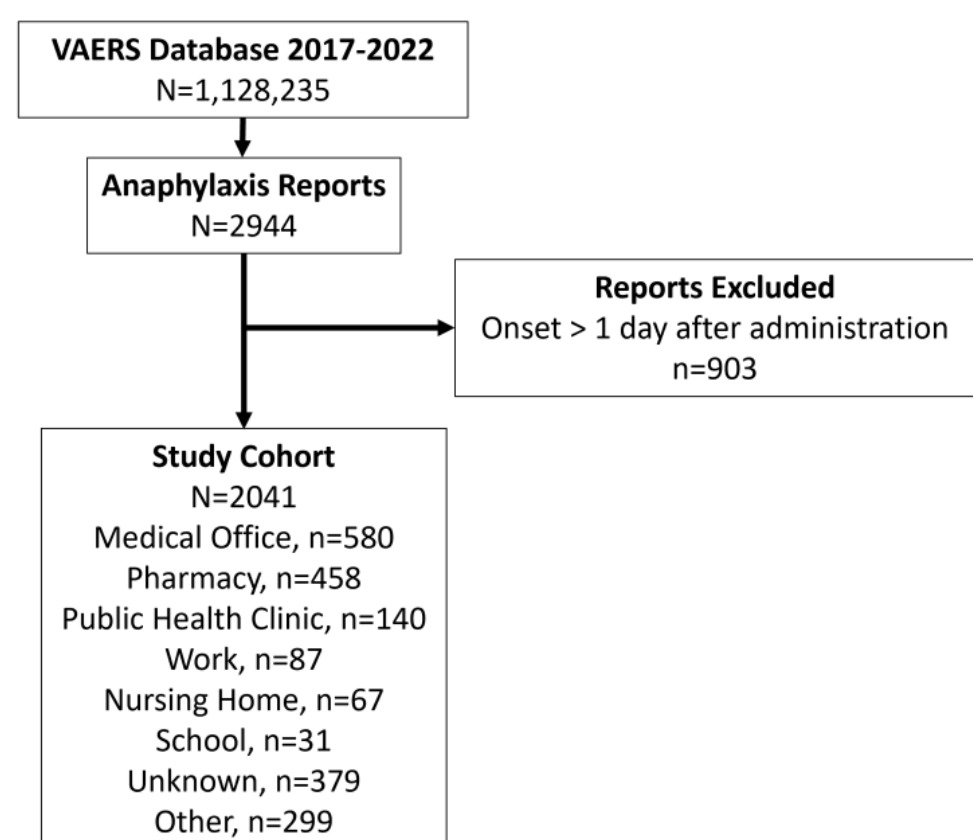
Figure 1. Flowchart of Inclusion Criteria and Cohort Selection.